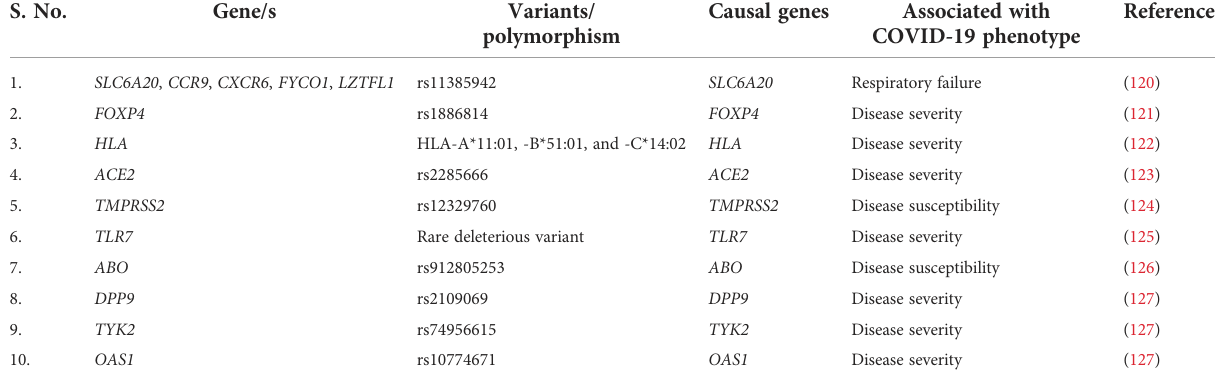
TABLE 4 Reported COVID-19 association with genetic variants and their respective